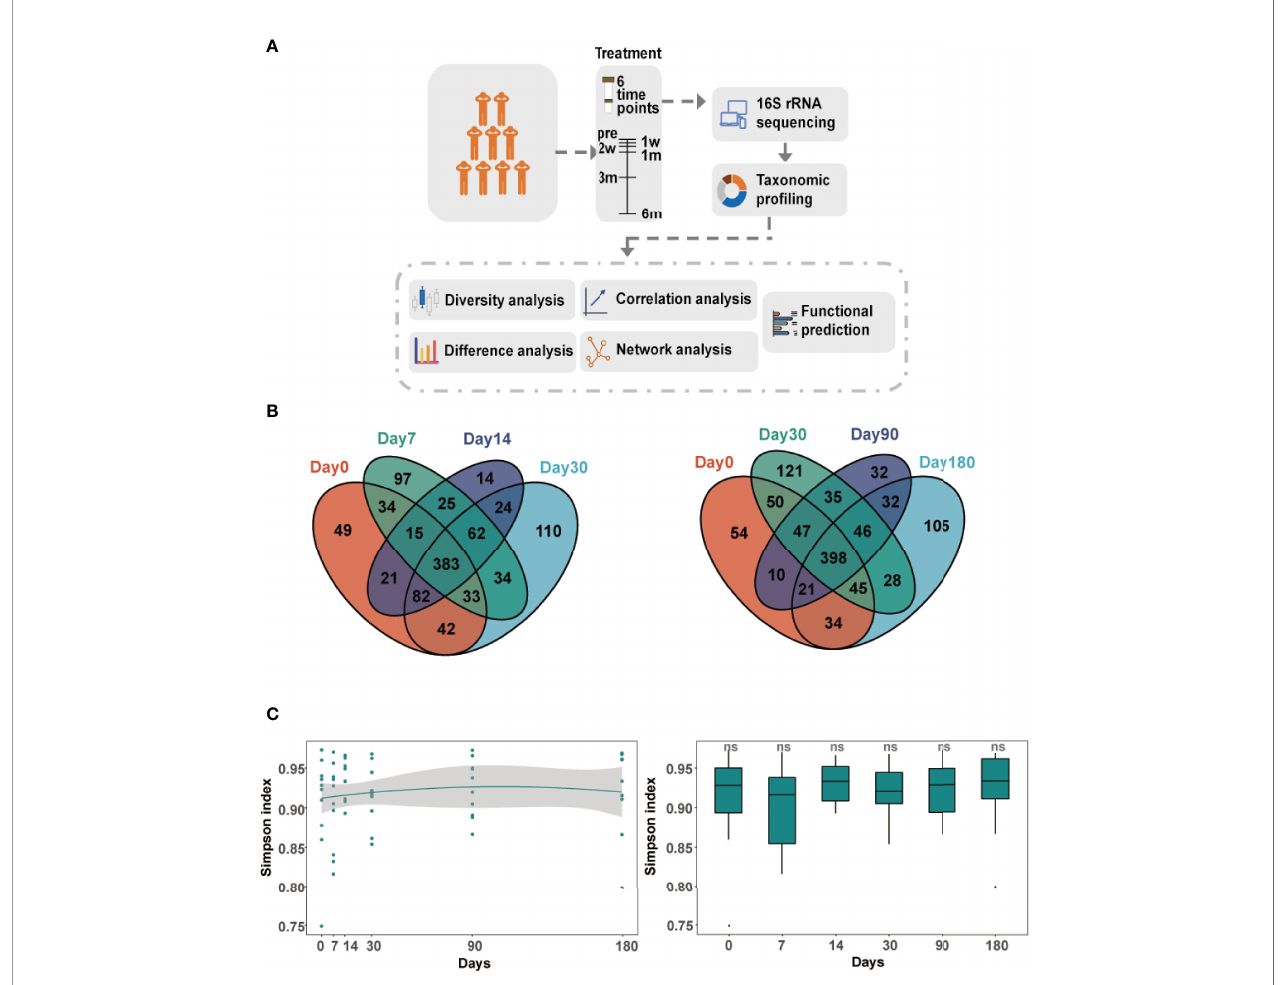
FIGURE 1 | Longitudinal dynamics of gingival crevicular fl uid (GCF) microbiota. (A) Overview of the study design and sample collection. (B) Venn diagram of amplicon sequence variants (ASVs) in six comparison groups. Day 0: before treatment; day 7: 7 days after treatment; day 14: 14 days after treatment; day 30: 30 days after treatment; day 90: 90 days after treatment; day 180: 180 days after treatment. (C) The alpha diversity of the GCF microbiota over time. The Simpson index compared between microbiota of each time point and before treatment. Signi fi cance was measured using the Wilcoxon rank-sum test ( P > 0.05, communities associated with the treatment, LEfSe analysis revealed 26 discriminative features (LDA > 2, P -value < 0.05, Figure 5B ; Additional File 8: Figure S3 ) at the class ( n = 2), order ( n = 4), family ( n = 10), and genus ( n = 10) levels. In the 180 days after-treatment group, the genera of discriminative features were Lactobacillus , Ochrobactrum , Desulfovibrio , Staphylococcus , Pedobacter , Microbacterium ,and Serratia ,whichweregroupedinto cluster 1; other clusters included Centipeda (cluster 2), Corynebacterium (cluster 2), and Bulleidia (cluster 6).